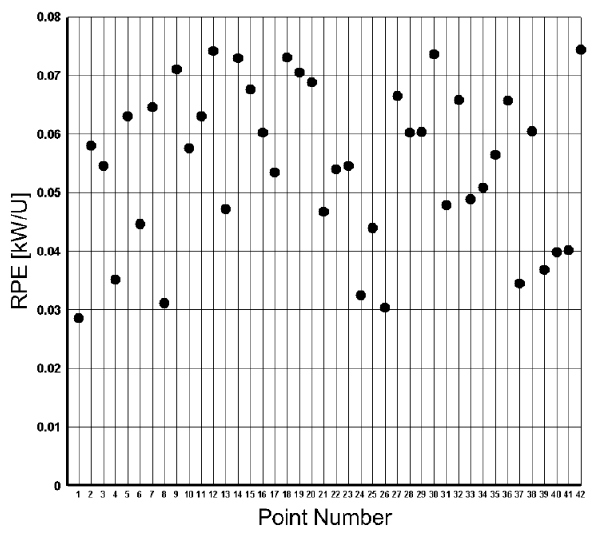
Figure 9. RPE for the optimal configurations of the Manzanares power plant. Table 4. Comparison of the design parameters and objective functions between selected solutions of the Pareto set and Manzanares power plant.